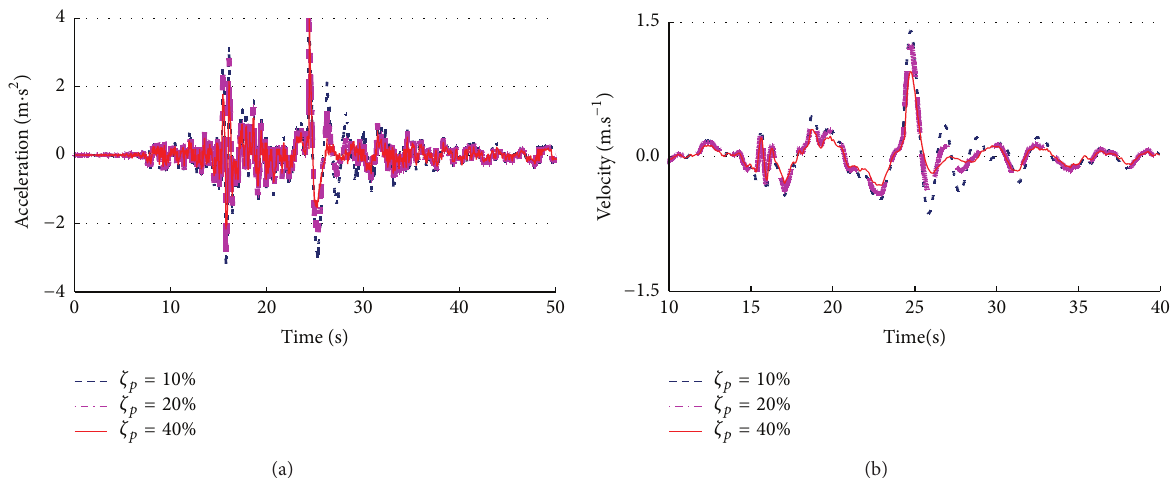
Figure 5: Simulated near-field pulse-like ground motion with various decaying factors to reproduce different numbers of pulses. (a) Time history of pulse acceleration; (b) time history of pulse